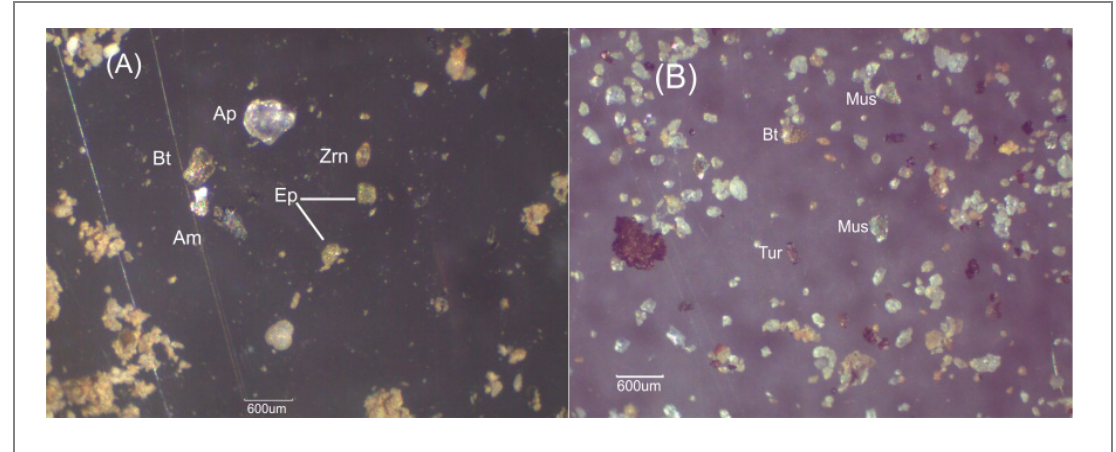
Figure 6 - (A): Heavy minerals at 38-43 cm depth SIS454. Ap-apatite, Bt-biotite, Ep-epidote, Zrn-zircon, Am-amphibole. (B): SIS-454, 120- 126cm depth. Tur-tourmaline, Mus-muscovite, Bt-biotite. Presence of iron